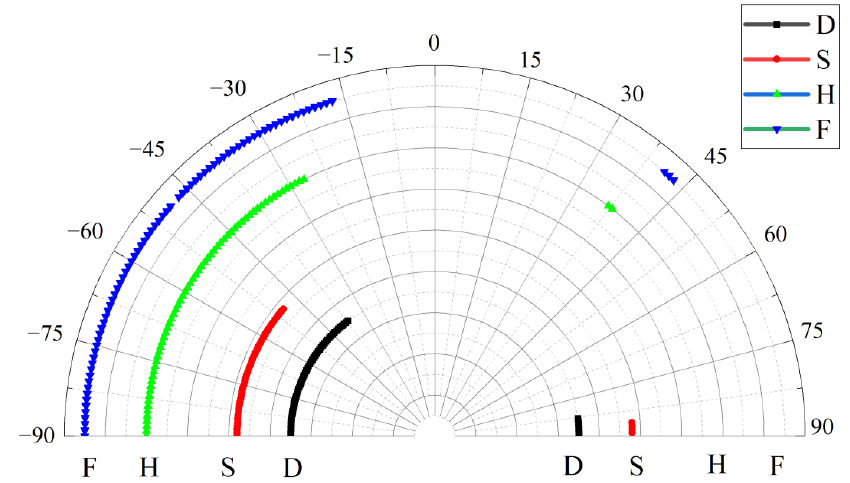
Table 3. Initial information of the ships for simulation in scenario 1.